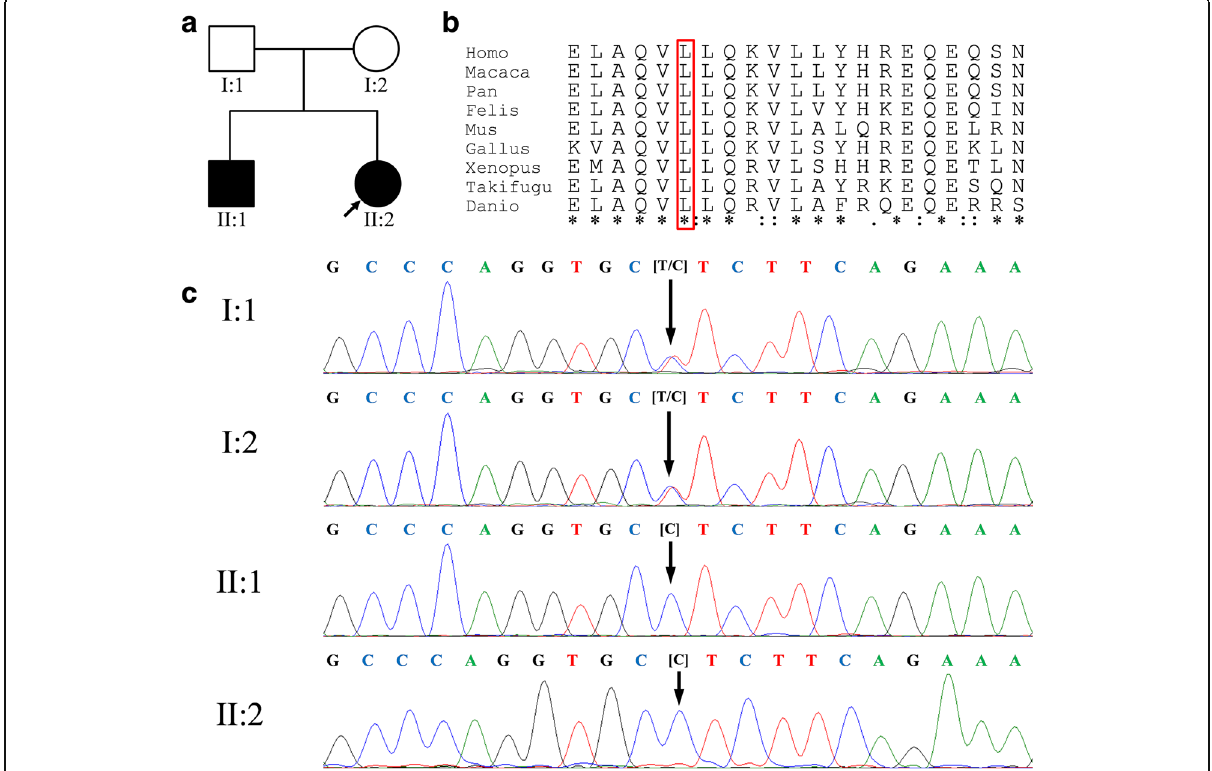
Fig. 1 a Pedigree of isolated methylmalonic acidemia with MMAA variants. The arrow denotes the proband, and affected family members are indicated by filled black symbols. b Multiple sequence alignment by use of ClustalX. The presence of a leucine residue at position 122 (highlighted with a box) was highly conserved across different species. c Validation of the MMAA gene mutation by Sanger sequencing. The proband and her affected brother are homozygous for c.365T>C, and their parents are heterozygotes (the variant is indicated by a black